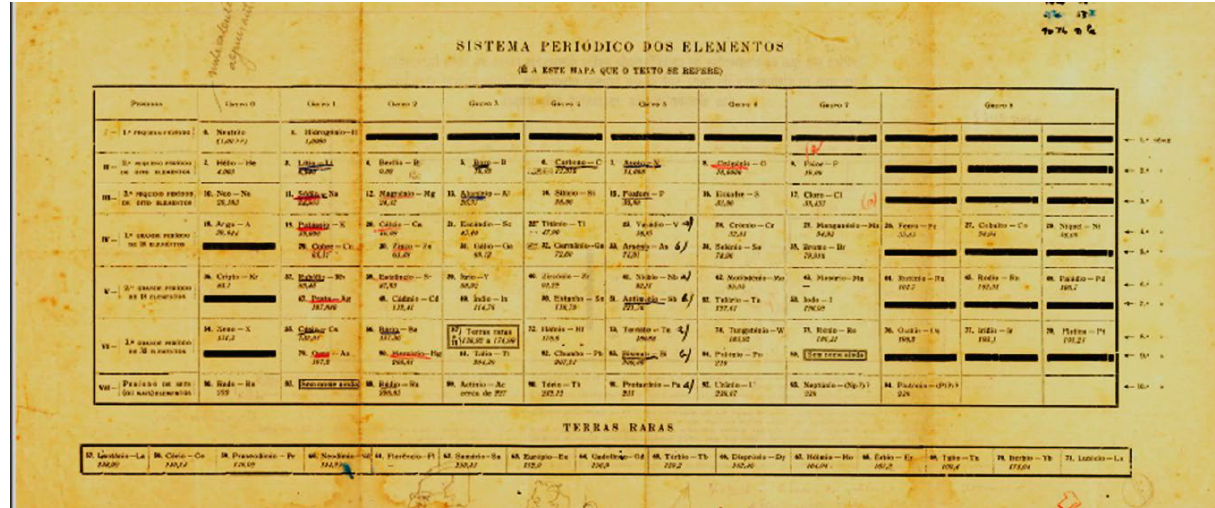
Figure 6a. Recto of the unfolding chart with periodic classification system included in F. Sena Esteves’ textbook (ref. 94).